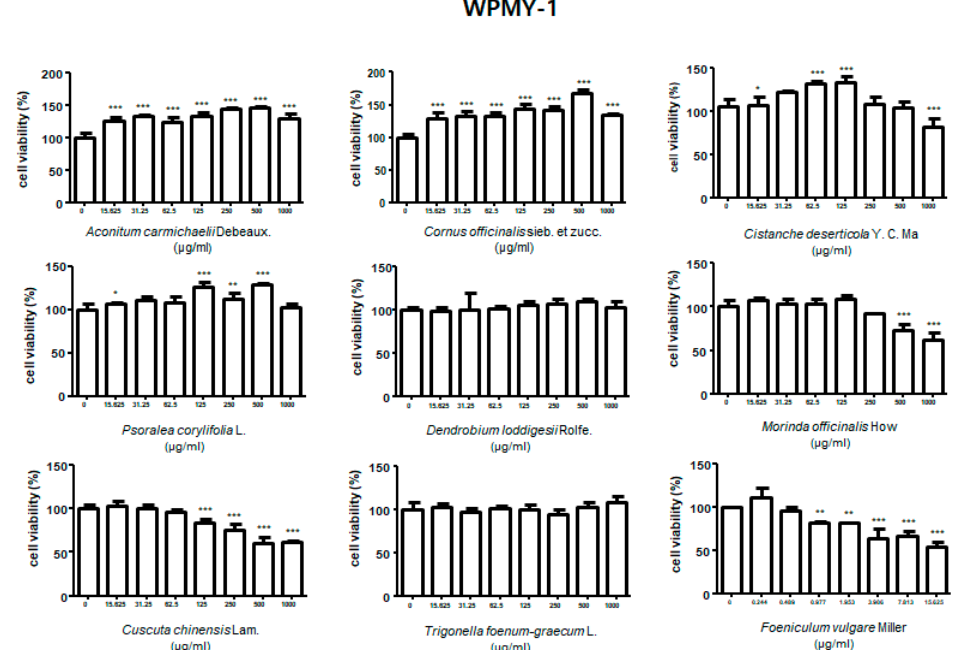
Figure 2. Effect of nine herbs of HBX-5 on the cell viability in WPMY-1 cells. WPMY-1 cells were treated with 0.25–1000 µ g / mL of HBX-5 components for 24 h. Values of cell viability were analyzed by ANOVA and Dunnett’s post hoc test for significances between each experimental group and resented as mean ± S.D. of three independent experiments (* p < 0.05, ** p < 0.01, *** p < 0.001 versus untreated control group).